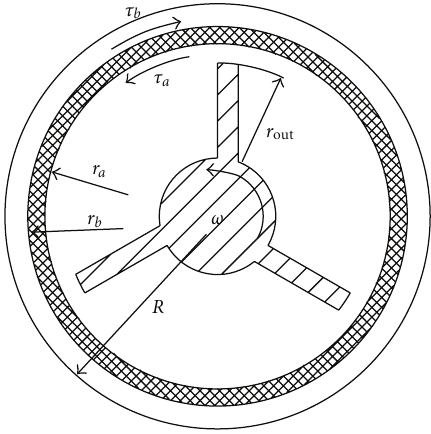
Figure 3: Flow at a section of the shearing chamber of the turbulence